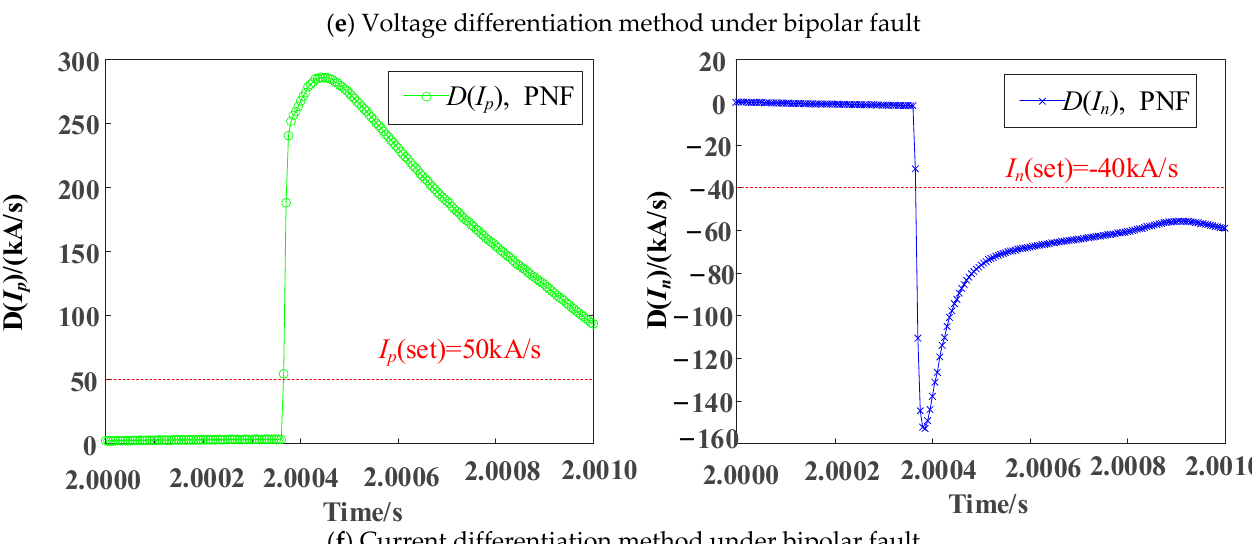
( e ) Voltage differentiation method under bipolar fault